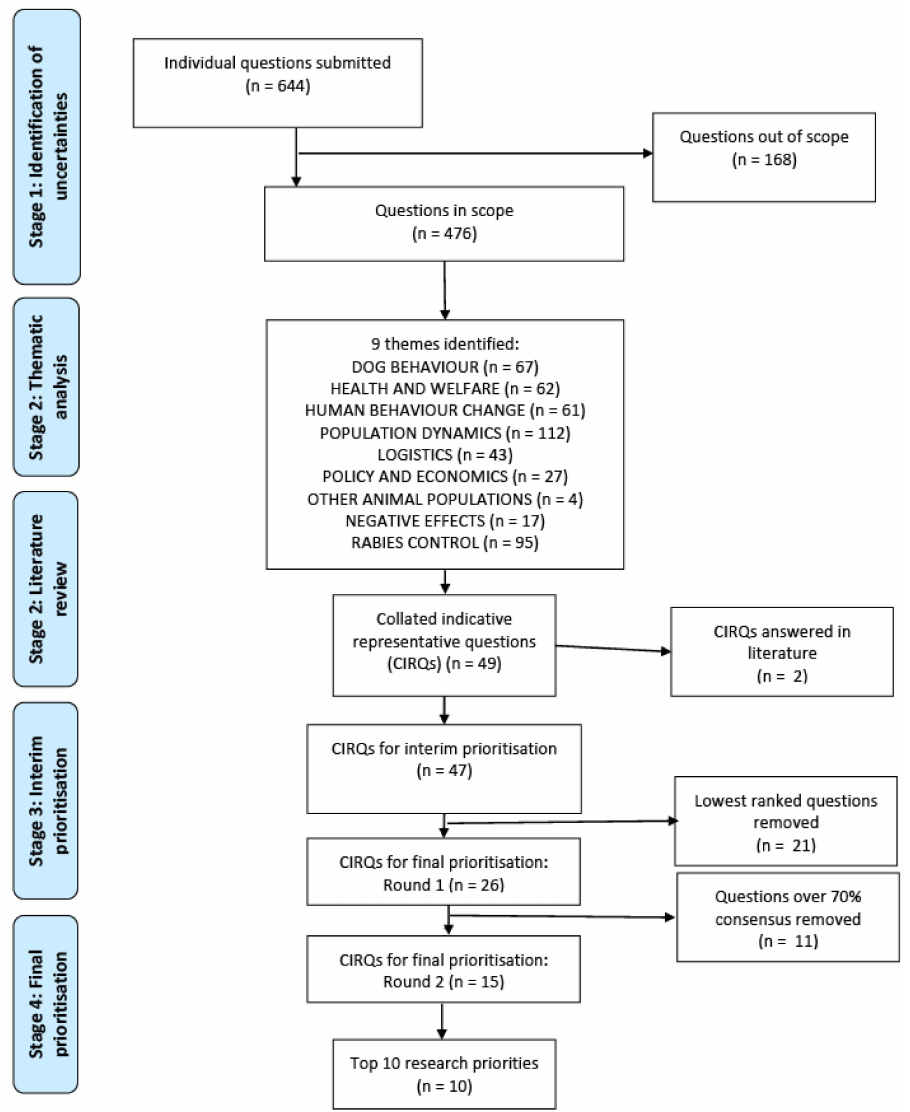
Figure 2. Flow diagram of prioritisation process and evolution of research questions from initial submissions to final